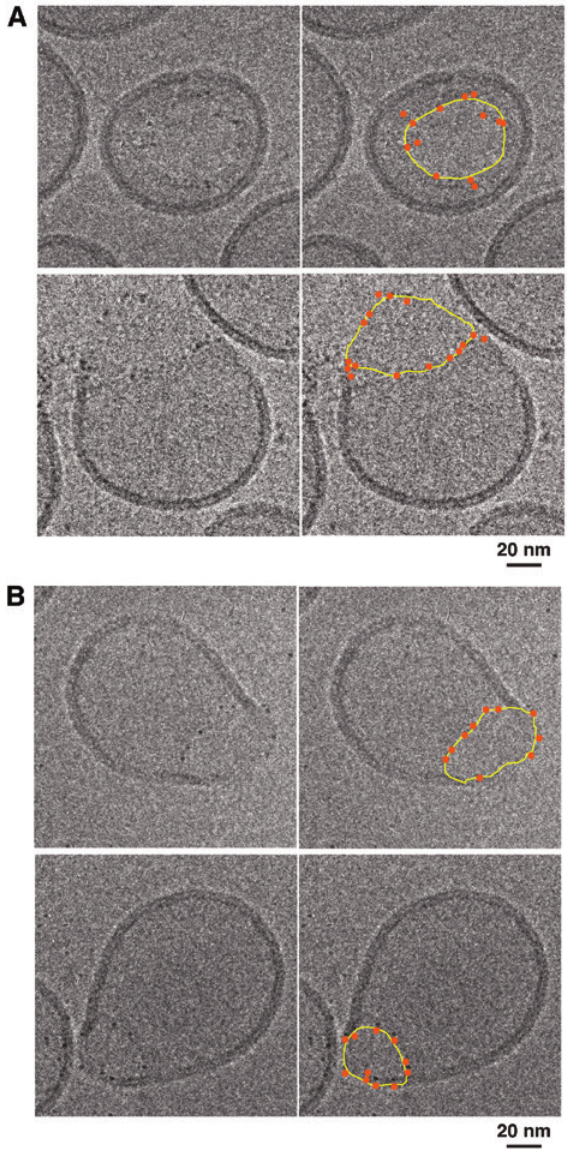
Figure 3: Nanogold labeling demonstrates that Bax is densely localized to the edges of the pore in liposomes. (A) Bax is directly con- jugated with nanogold at the flexible N-terminal helix and incubated with liposomes together with cBid. The sample was plunge-frozen manually and inspected with a Tecnai G2 (Sphera) scope. The images were captured in a CCD camera. The particles densely decorate the pore edges. The orange dots denoting gold particles and the yellow lines showing the pore edges are added manually to aid the interpretation of the raw and low-contrast images on the left. Specific localization of the gold particles on the pore edges was confirmed in an objective image analysis [52] (also applied to B). (B) His-Bax and cBid were incubated with liposomes and N ++ -nanogold was added to label His-Bax. Nanogold particles localize to the pore edges just like gBax. Its density was not as high as gBax, hinting that there may be steric hindrance to the His-tag, or the labeling was not as